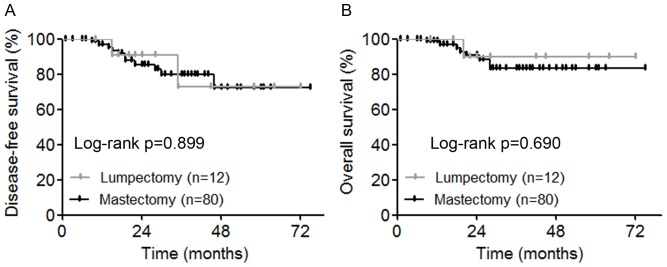
Kaplan-Meier estimates of disease-free survival (A) and overall survival (B) between the 12 patients received lumpectomy and the 80 patients received mastectomy.